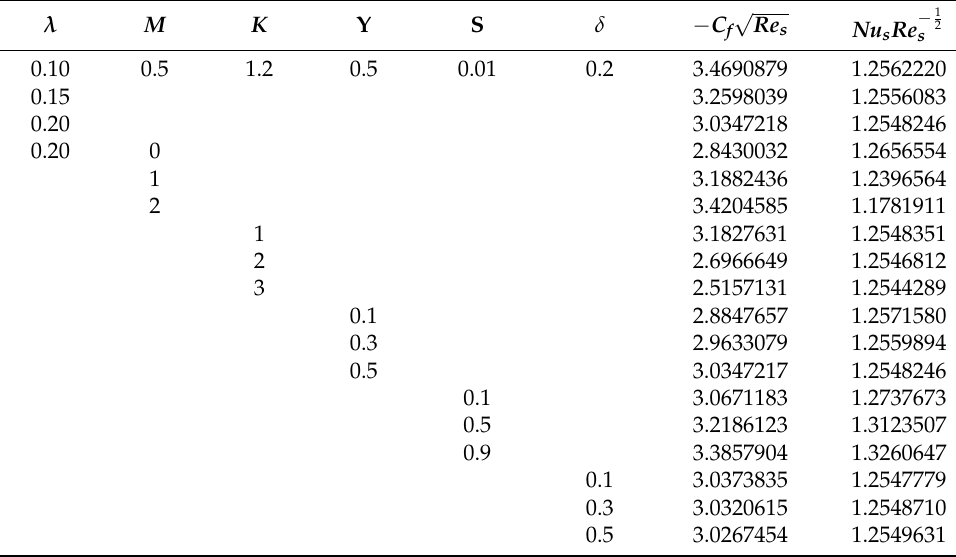
√ − 1 2 s . Re s and Nu s Re